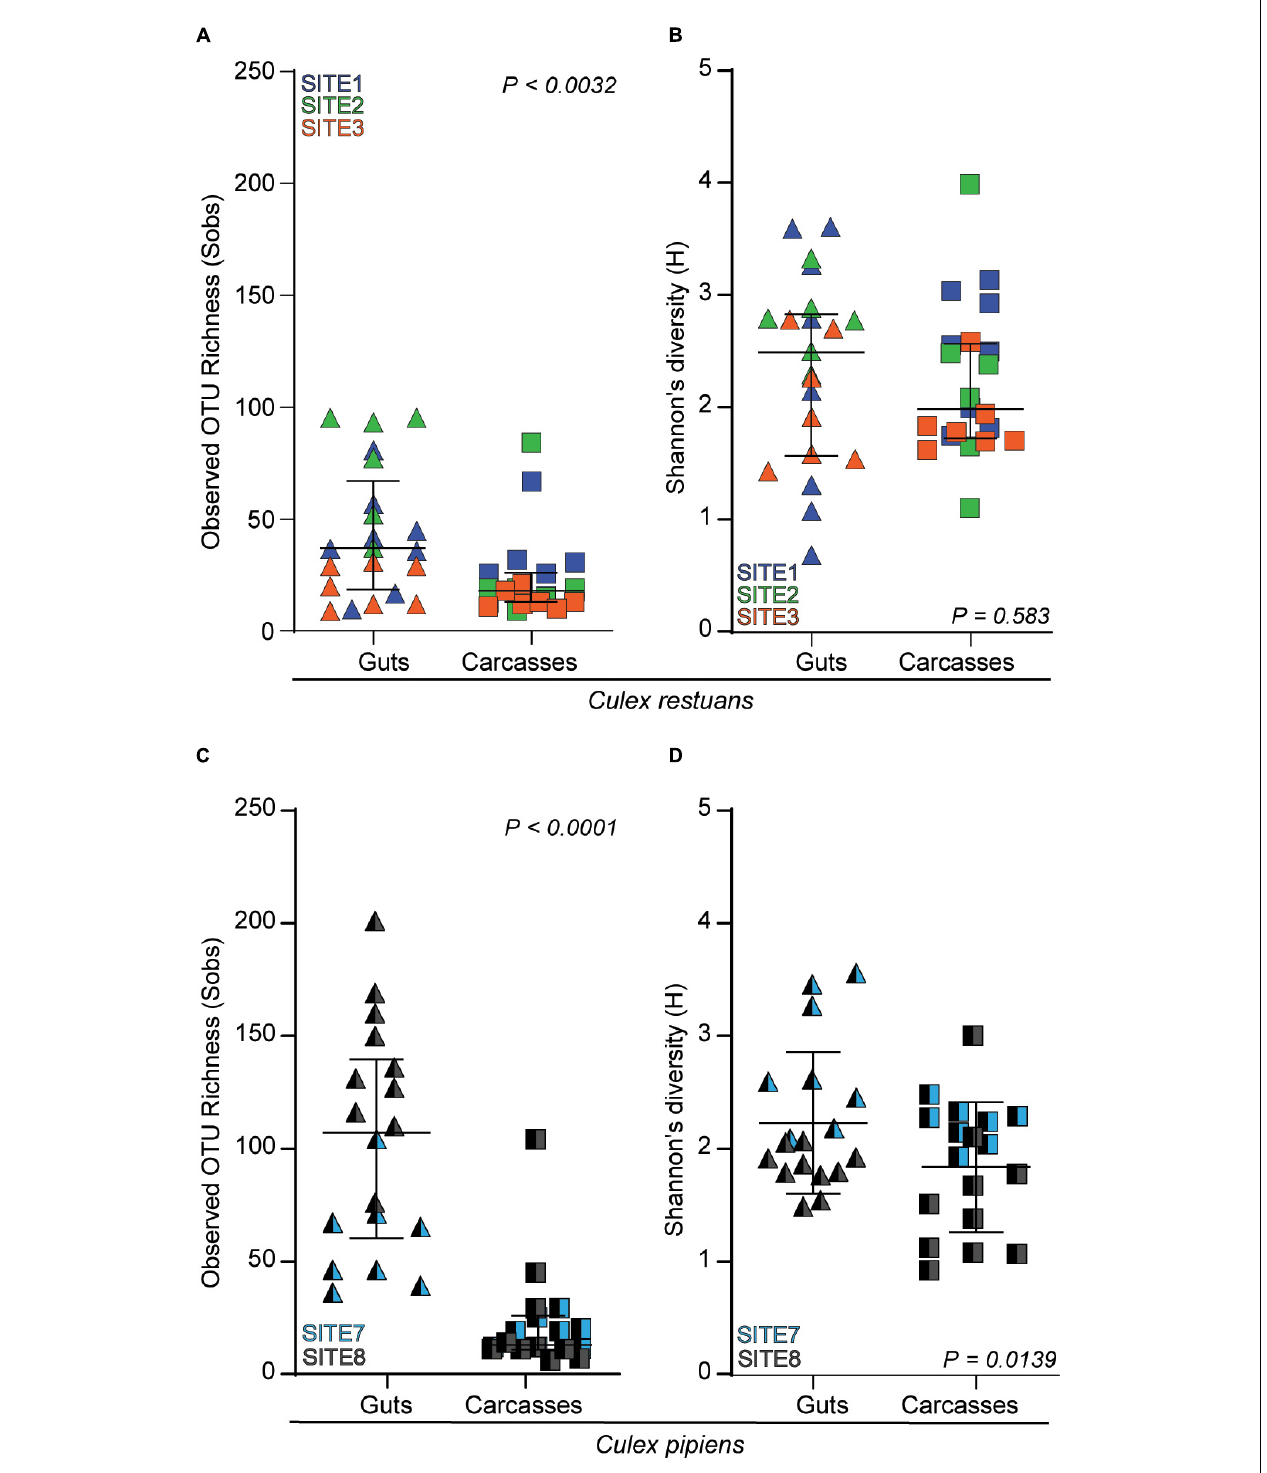
FIGURE 5 | Alpha diversity indices as measured by observed OTU richness (Sobs) and Shannon’s diversity (H) of larval guts and carcasses across collection sites. (A) OTU richness in Cx. restuans guts and carcasses. (B) Shannon’s diversity in Cx. restuans guts and carcasses. (C) OTU richness in Cx. pipiens guts and carcasses. (D) Shannon’s diversity in Cx. pipiens guts and carcasses. Statistical significance was determined using a Wilcoxon signed-rank test.